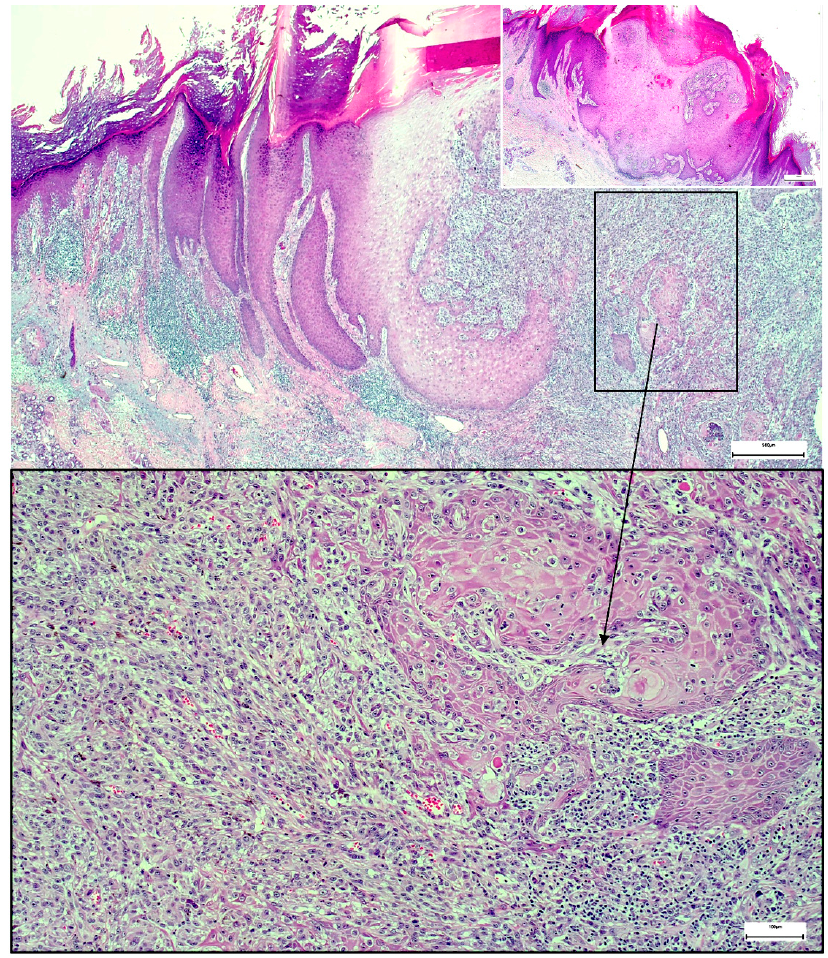
Figure 2. Collision tumor consisting of keratoacanthoma and melanoma, Hematoxylin and Eosin stain (H&E). The small insert on the upper right side shows the edge of the keratoacanthoma with characteristic architecture and large pale keratinocytes.